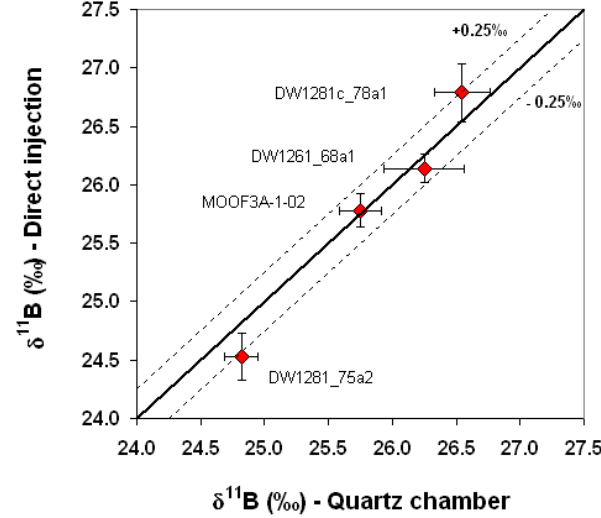
Fig. 3. Comparison of MC-ICPMS analyses using direct injection (d-DIHEN) and conventional introduction for Porites referenced DW1281c 78a1, DW1261 68a1, DW1281 75a2 and MOO3A-1- 02. δ 11 B results show an excellent agreement of the two introduc- tion technique within the external reproducibility considered here of ± 0.25‰. Error bars are the standard deviation calculated from the “n” measurements for each sample (Table